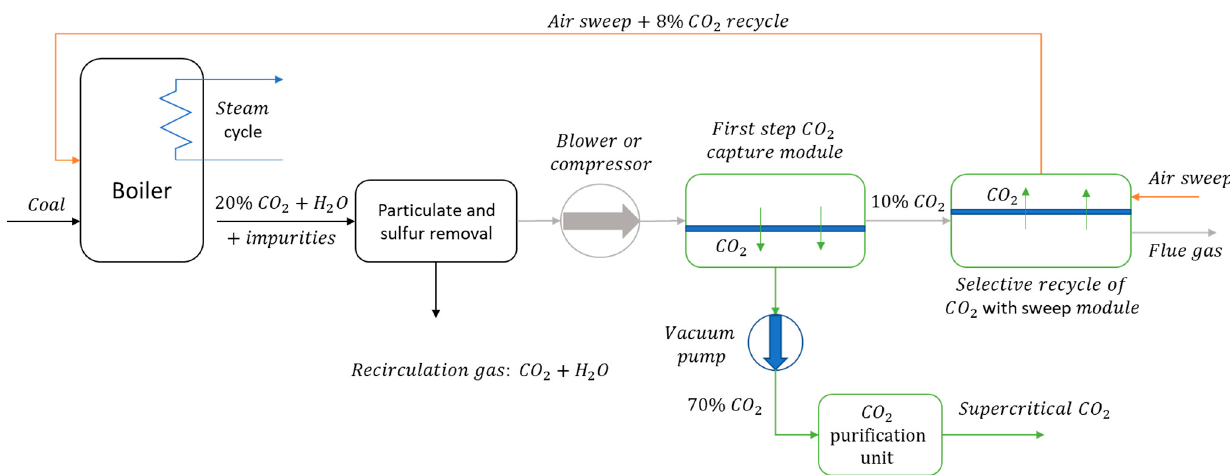
Figure 8. Simplified diagram of the Membrane and Technology Research Institute (MTR) selective recycle CO 2 capture process at a coal-fired power plant using PolarisTM membrane in separation modules [22].